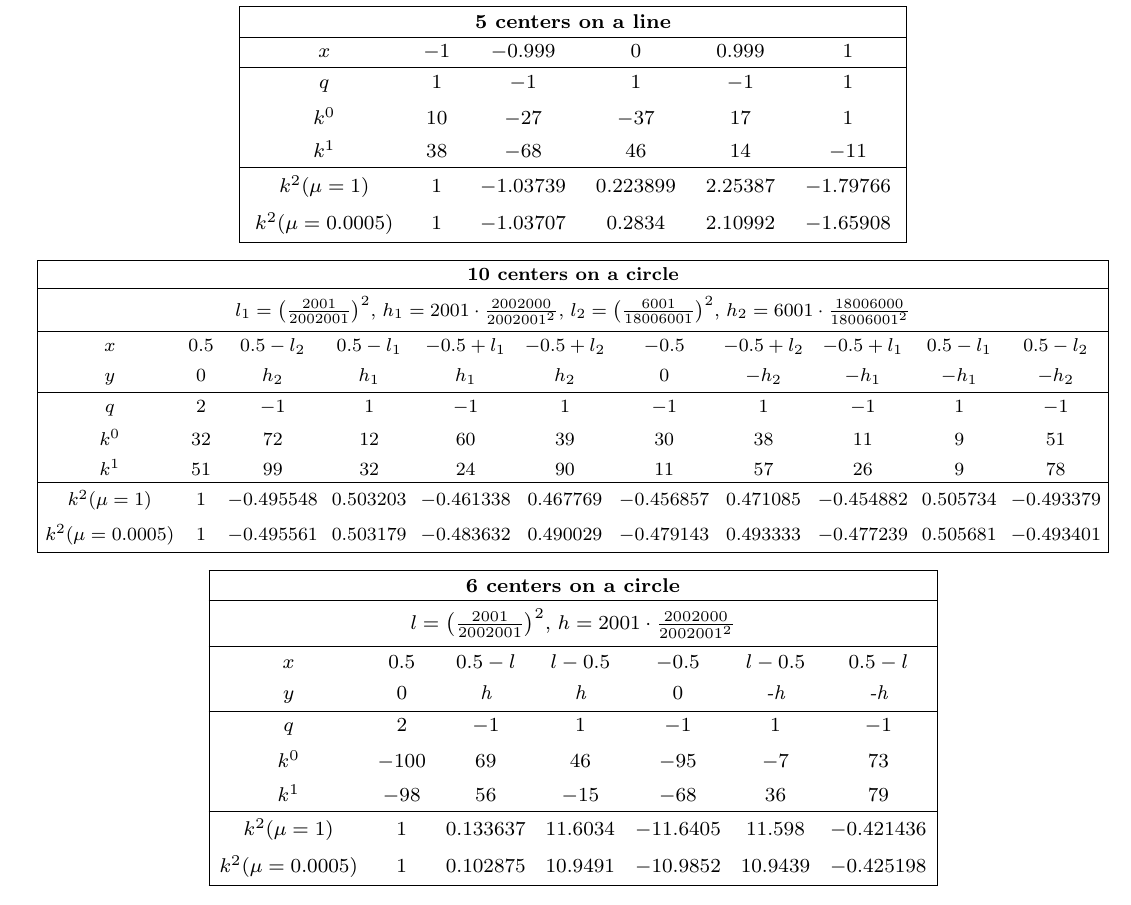
Table 1 . Input and output parameters of solutions. l 1 cases. Output parameter values shown are only